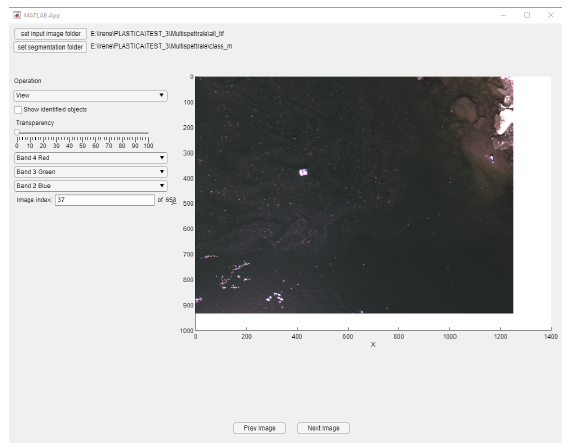
Figure 3. Graphical user interface window in View mode.